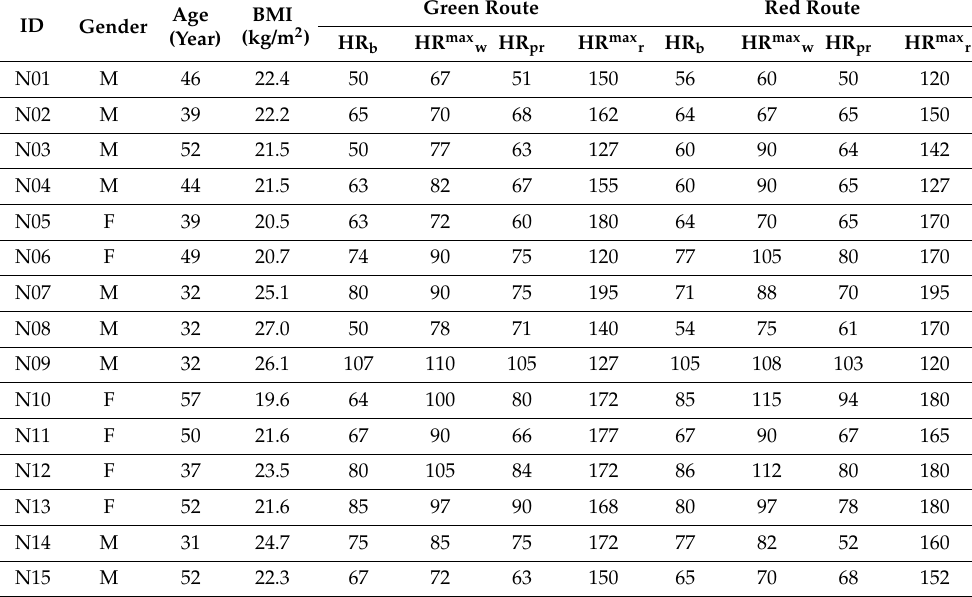
Table 1. Demographic data and heart rate values measured before walking (HR b ) and before running (HR pr ) for both green and red routes. Note: HR max w and HR max r are the maximum values reached during walking and running,